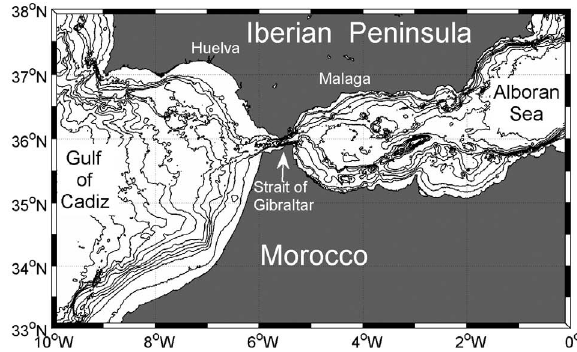
f iG . 1. – Map of the study area showing bathymetric contours of 100, 200, 600, 800, 1000, 1500, 2000, 2500 and 3000 m and the location of the cities of Huelva and